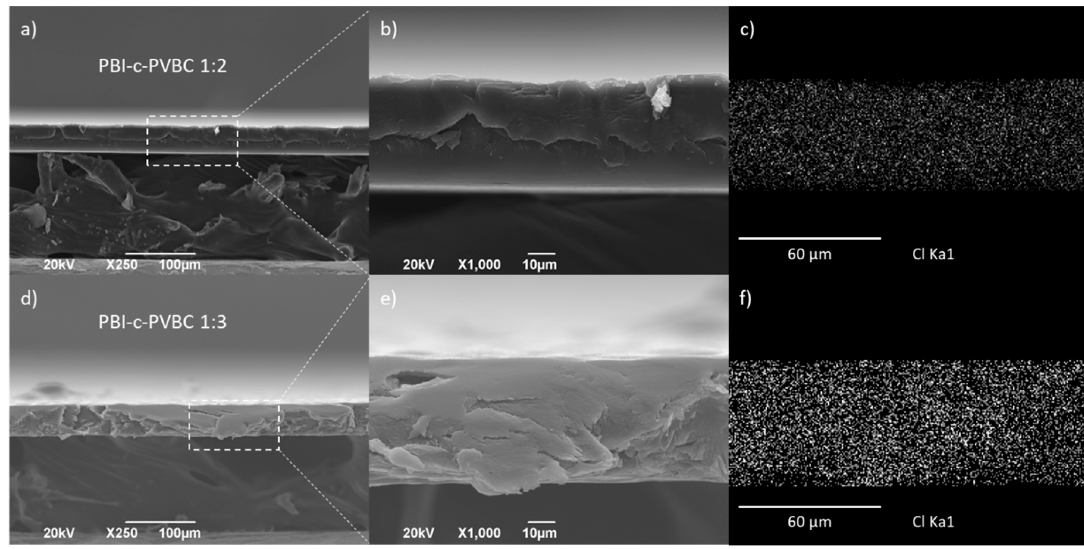
Figure 4. Cross-section ( a , d ) SEM micrographs; ( b , e ) detailed inset and ( c , f ) corresponding Cl EDX mapping of PBI-c-PVBC 1:2 and 1:3 membranes, respectively.